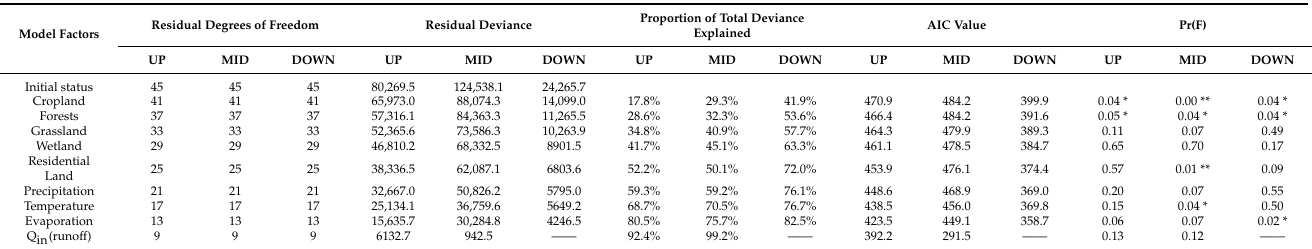
Table 2. Analysis of deviance for GAMs fitted to the streamflow consumption